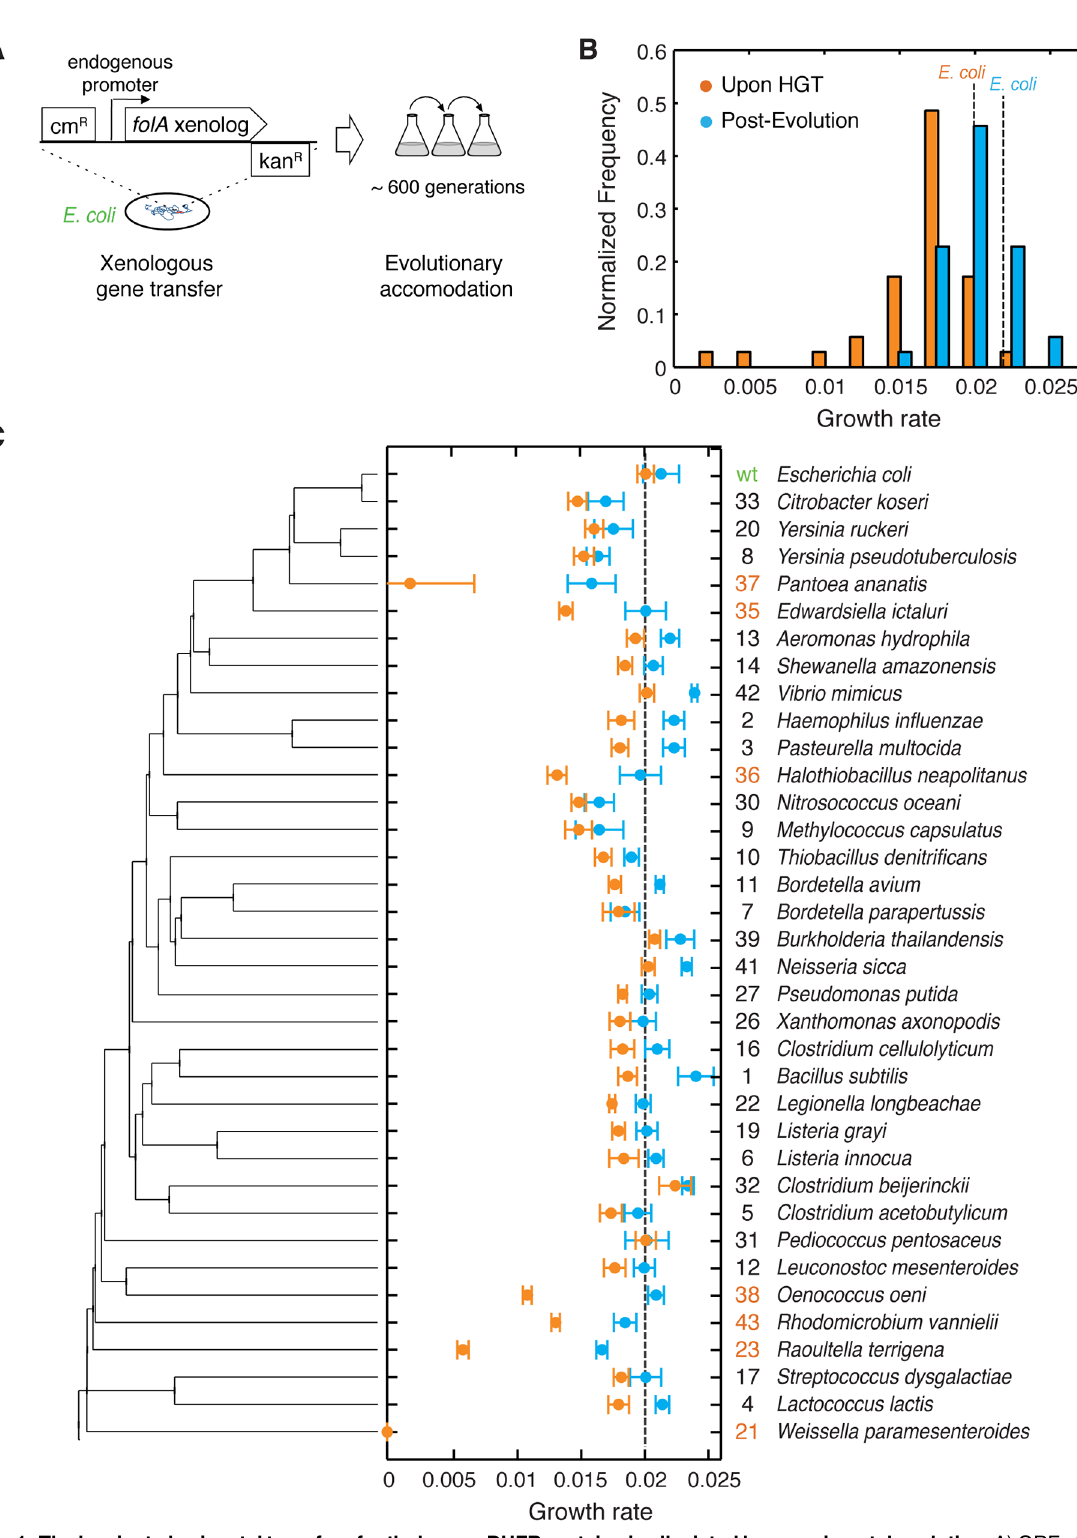
Fig 1. The barrier to horizontal transfer of orthologous DHFR proteins is alleviated by experimental evolution. A) ORF of folA gene encoding DHFR in the E . coli chromosome is replaced with orthologs from 35 other mesophiles, while preserving the endogenous promoter. The strains carrying the orthologous DHFR replacements are evolved for 31 serial passages (~600 generations) under standard conditions. B) Distribution of the growth rates